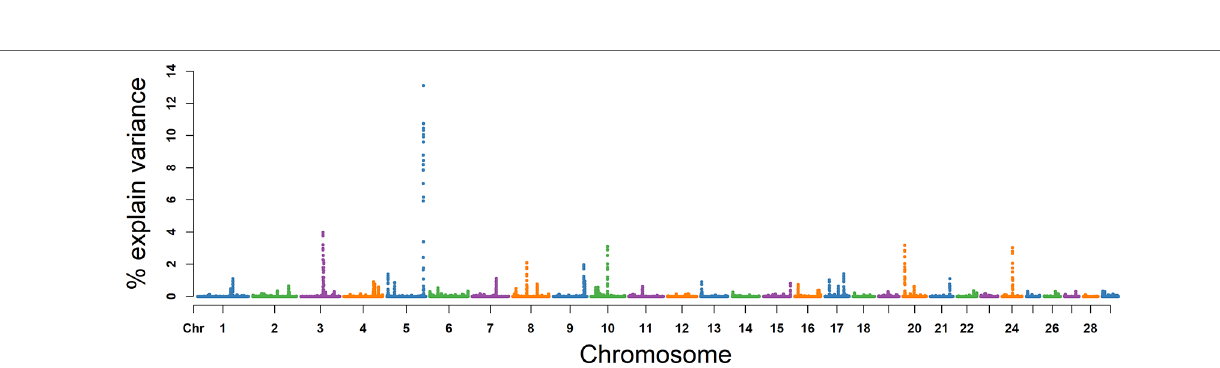
FIGURe 6 | GWAS results of progressive sperm motility (MS) in Holstein bulls of China. Each dot represents one SNP. The X-axis represents 29 autosomes, respectively. The Y-axis represents the percentage of the explained variance by SNP.